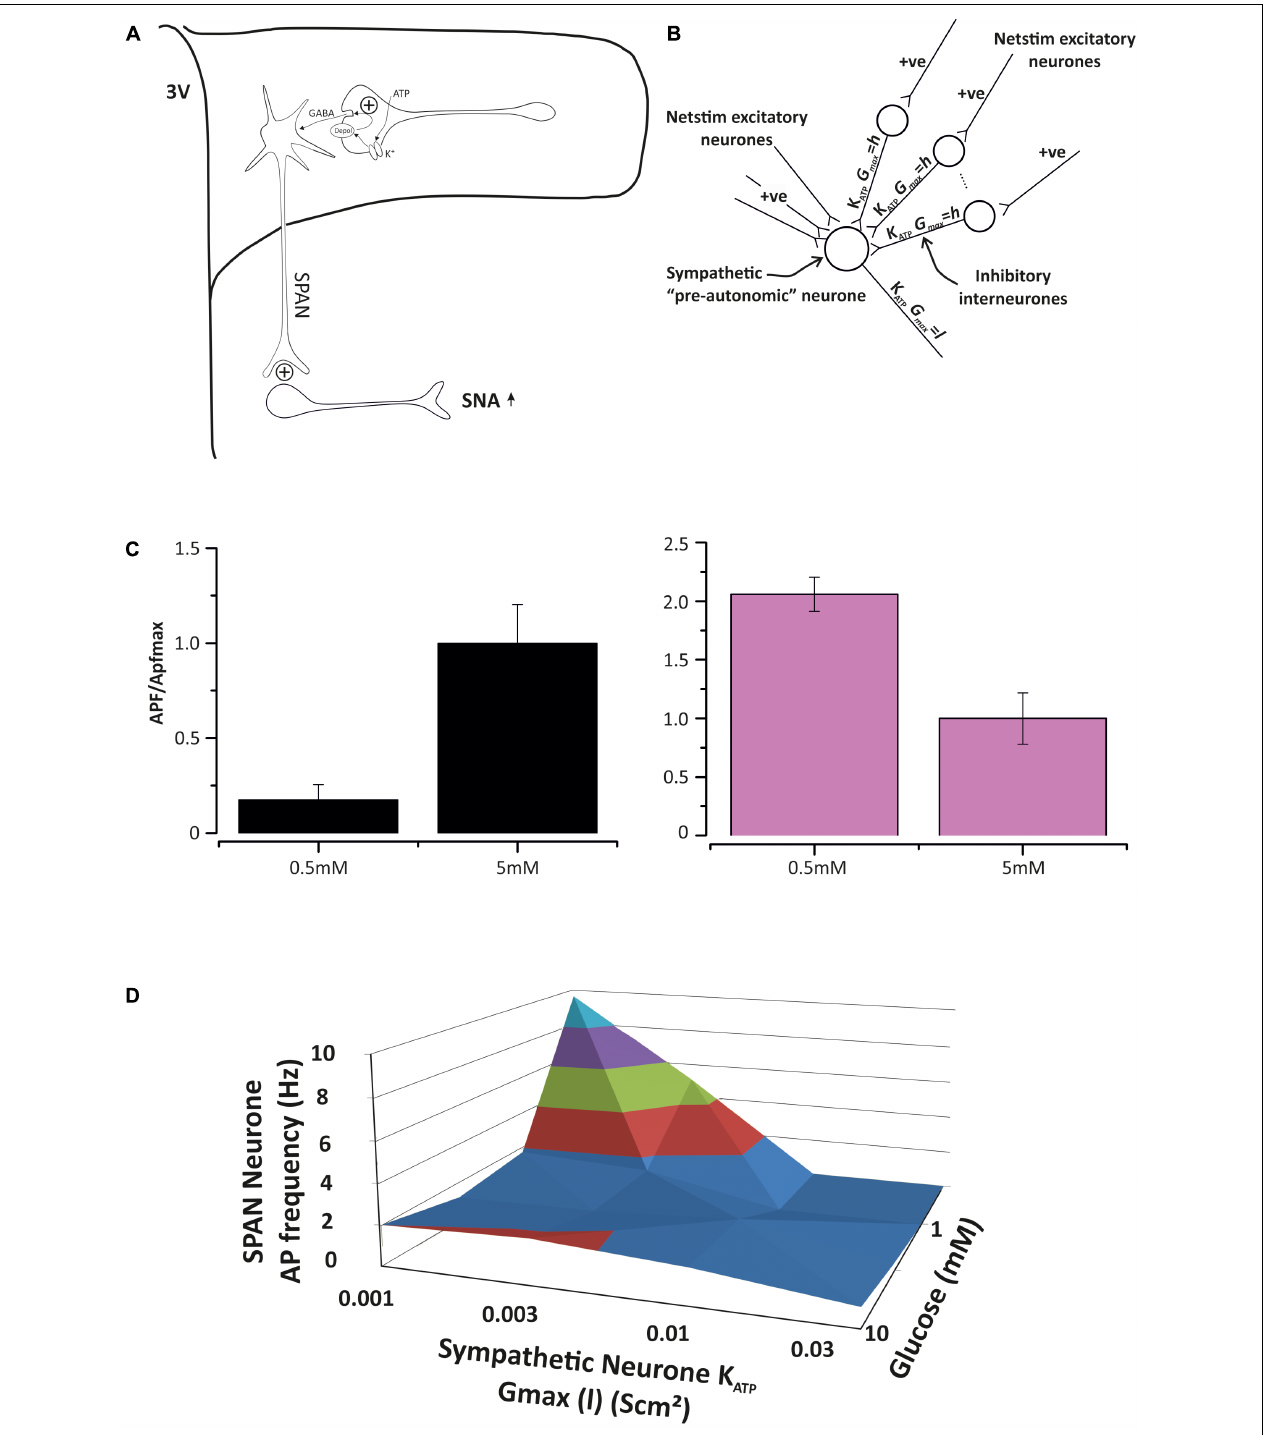
FIGURE 5 | Model of pre-autonomic neurone regulation by K ATP channels. (A) The base model, spinally-projecting neurones (SPAN) receive excitatory and inhibitory input in the PVN and activate spinal preganglionic neurones. Both the SPAN and inhibitory interneurons express K ATP channels, but at different densities (Shiraishi, 1987). (B) Parameterizing the model with different K ATP conductances (maximum) leave the cell to respond differently to glucose levels. (C) On the left, with low SPAN K ATP expression, increasing glucose excites the SPAN, but when K ATP expression is sufficiently high, elevated glucose will decrease action potential frequency (APf). This paradox is accounted for by the relatively greater effect of glucose on the inhibitory input neurone. (D) A 3D dose response curve for ATP ion channel expression density (x-axis) and glucose concentration (z-axis) against the sympathetic neurone action current frequency (y-axis) generated from several experiments such as those in (C) .